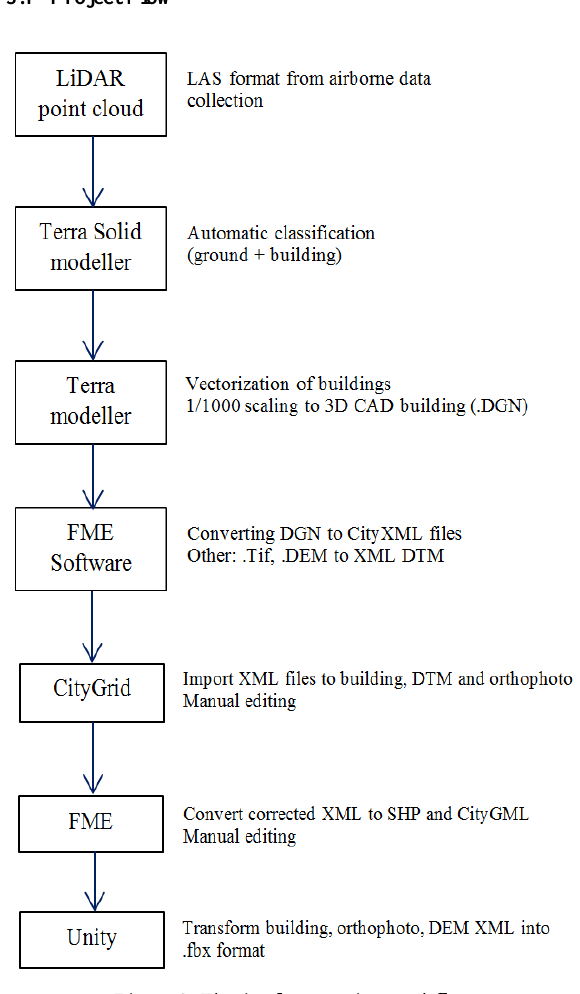
Figure 10. The selection of a particular building.